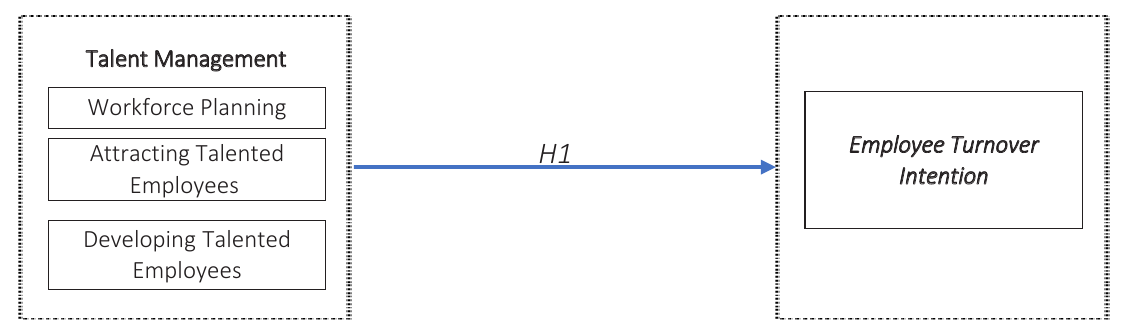
Figure 1. Research